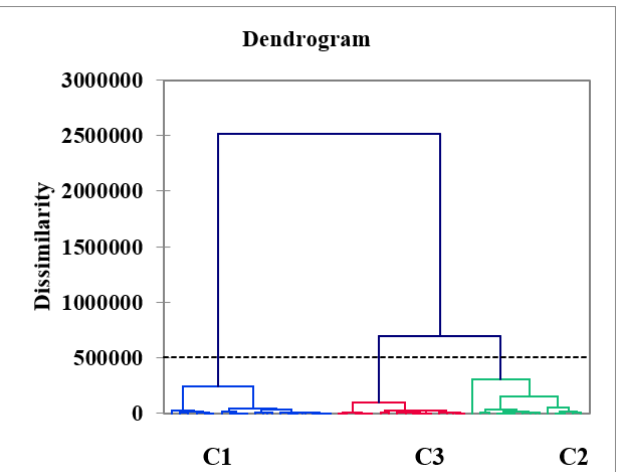
Figure 7. Potential clusters described after Ward’s classification that grouped PHEs into three clas- ses, C1, C2, and C3, in the Adenzai area.